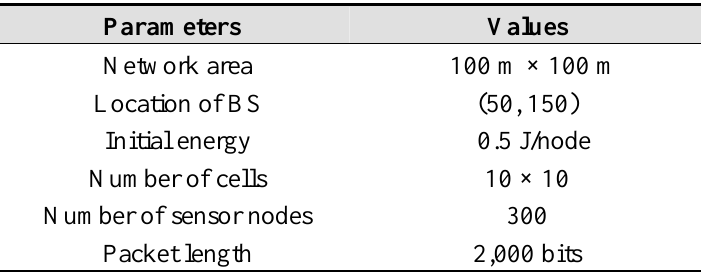
Table 1. Parameters for the